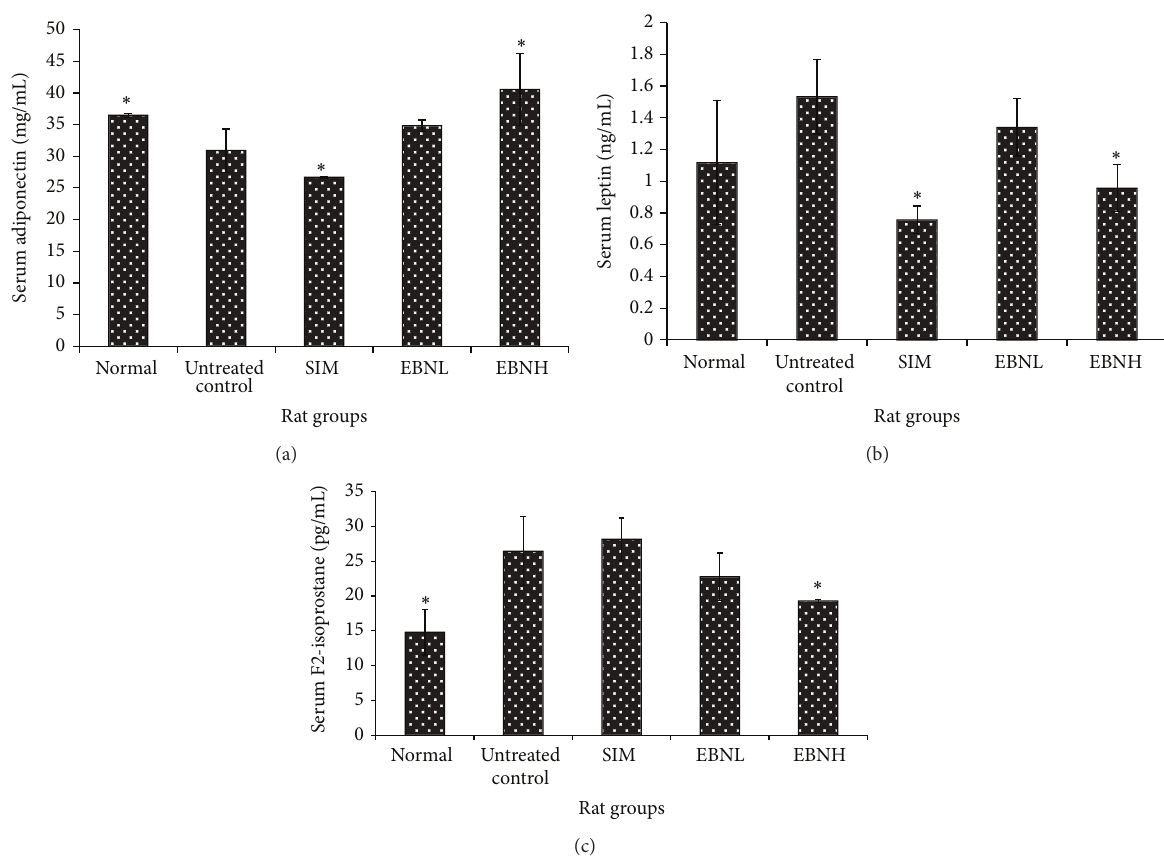
Figure 4: Effects of edible bird’s nest (EBN) on (a) serum adiponectin, (b) serum leptin, and (c) serum F2-isoprostane in high fat diet- (HFD-) fed rats. Groupings are similar to Figure 2. ∗ indicates significant difference ( 𝑃 < 0.05 ) in comparison with untreated